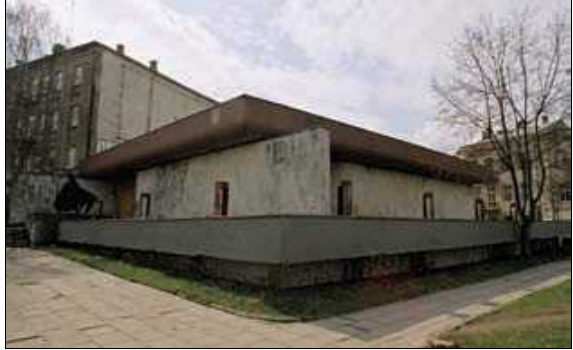
Figs. 15, 16. Fu­rnitu­re Store Pavilion in Vilniu­s (arch. e. N. bu­čiūtė) in 1974 reconstru­cted in 1990